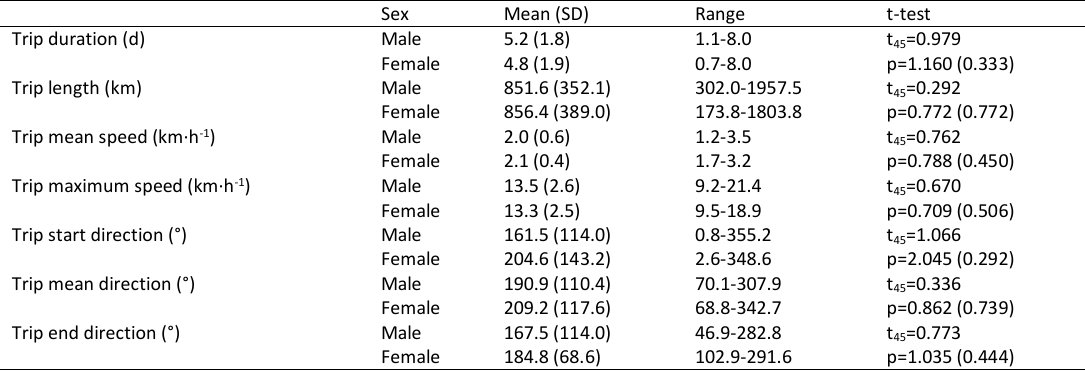
Table 7. Summary of foraging trip metrics for snow petrels from Ile des Pétrels, Adélie Land, East Antarctica. For t-tests homogeneity of variances we checked using a Brown and Forsythe tests (Brown and Forsythe 1974), corrected p values are reported (uncorrected in brackets). Significant differences with a false detection rate of 0.10 are shown in bold.